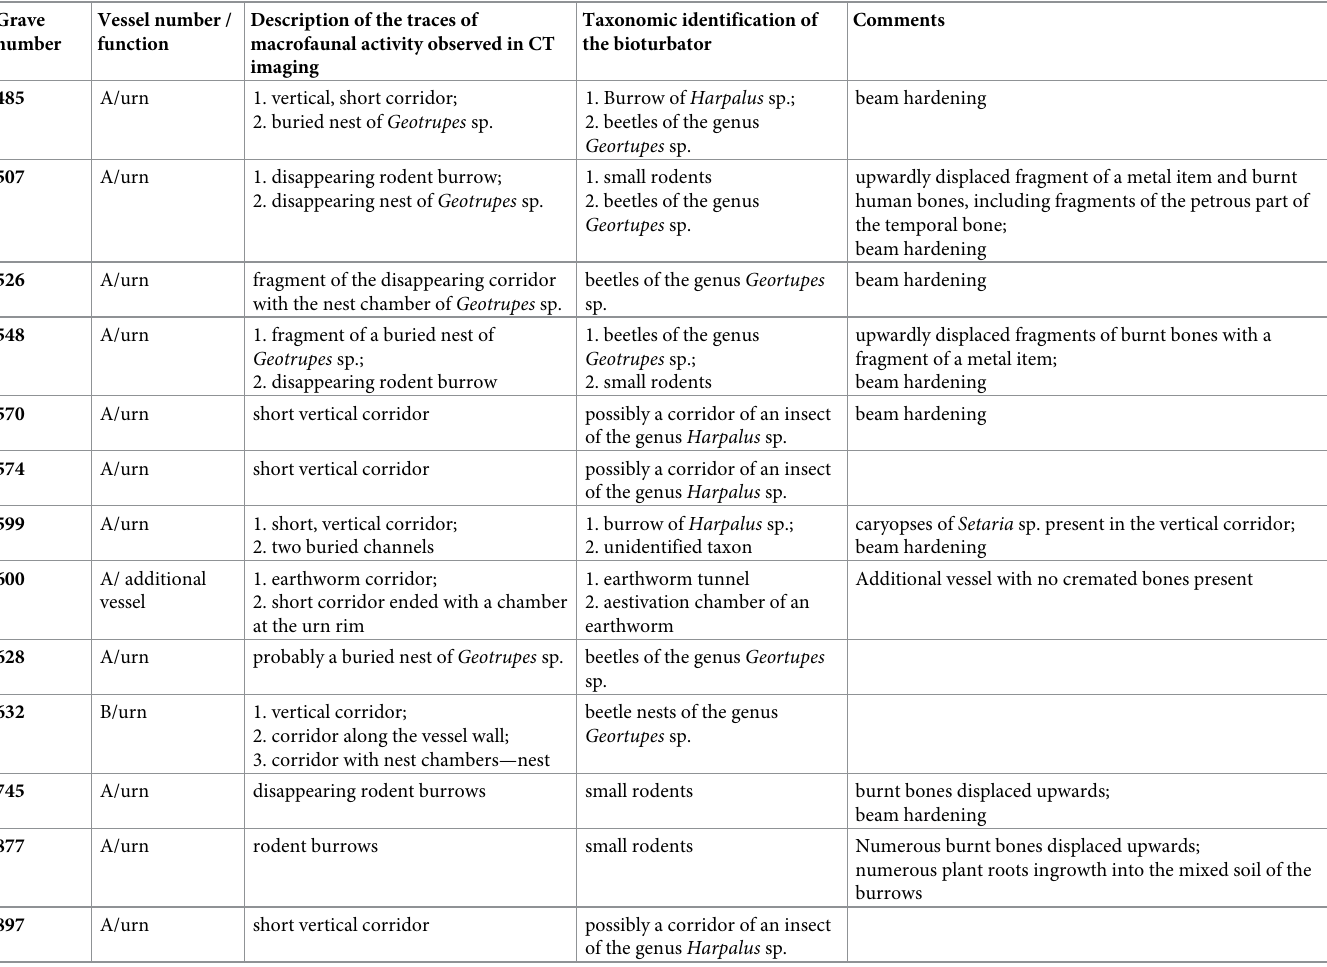
Table 3. Characteristics of the traces of macrofaunal activity observed in the CT scans and taxonomic identification of particular bioturbations. Grave